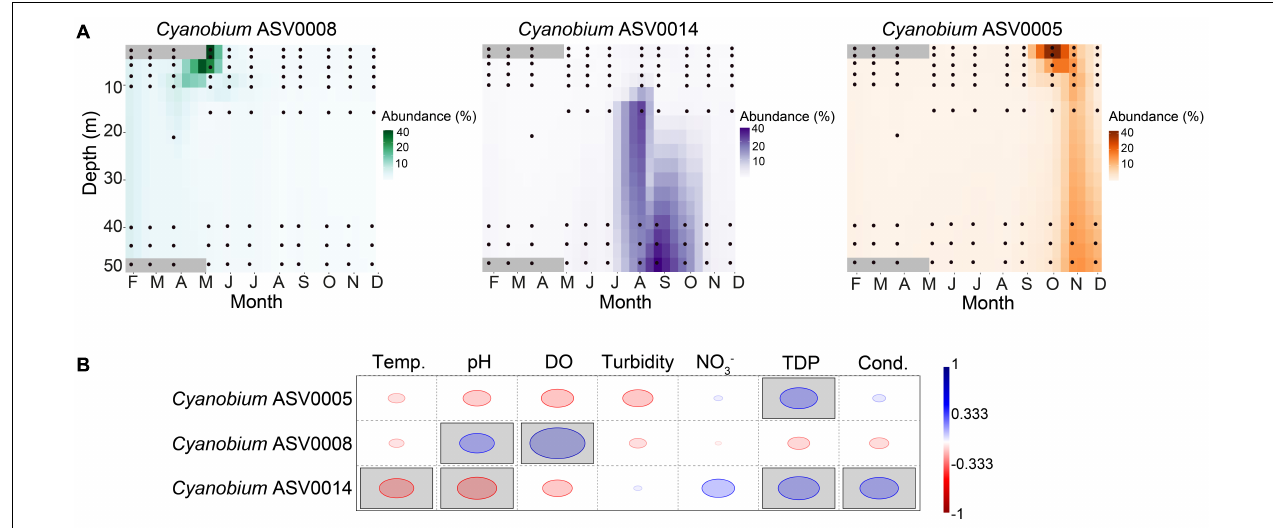
FIGURE 6 | Dynamics of the three most abundant Cyanobium ASVs and correlation with environmental parameters. (A) Heatmaps show the spatiotemporal distribution across the water column of Lake Tiefer See. Data were interpolated for 10 days and 3 m water depth. Black circles represent the depths of water sample collection. (B) Rank-based Spearman correlation of the most abundant Cyanobium ASVs with lake physicochemical parameters in Lake Tiefer See. Gray-shaded squares are significant at p < 0.05 with Bonferroni p -value correction. Blue circles show positive while red circles show negative correlation. Temp. = Temperature, DO = dissolved oxygen, NO 3 − = nitrate, TDP = total dissolved phosphorus, Cond. =